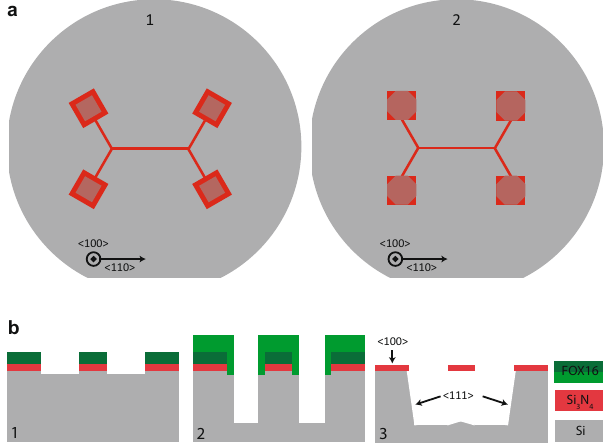
Fig. 6 Design considerations in KOH-based undercut of Si 3 N 4 on Si. a Appropriate design limits the undercut of the beam supports and prevent deformation and relaxation of the Si 3 N 4 fi lm. The KOH etch fully removes the silicon below the beam (dark red), while the Si 3 N 4 at the supports is still partly connected to the underlying silicon (light red). If the fi nal beam segments are connected to their supports at a 90° angle (1), the supports will be undercut at the clamping points, creating an overhang region which increases dissipation (see main text). Aligning the supports along the slow- etching planes (2) ensures that the undercut is limited to the corners of the pads and prevents the creation of an overhang at the clamping points. b Main steps of the process fl concomitantly deposited on the back side as a mask for the KOH undercut of the devices, and pattern rectangular membrane windows with UV lithography, aligned to the front side through appropriate reference markers. During this step, a layer of photoresist protects the front side layer from contamination and mechanical damage by contact to the wafer holders of the optical exposure and plasma etching tools. The dimensions of the windows are corrected with respect to the membrane